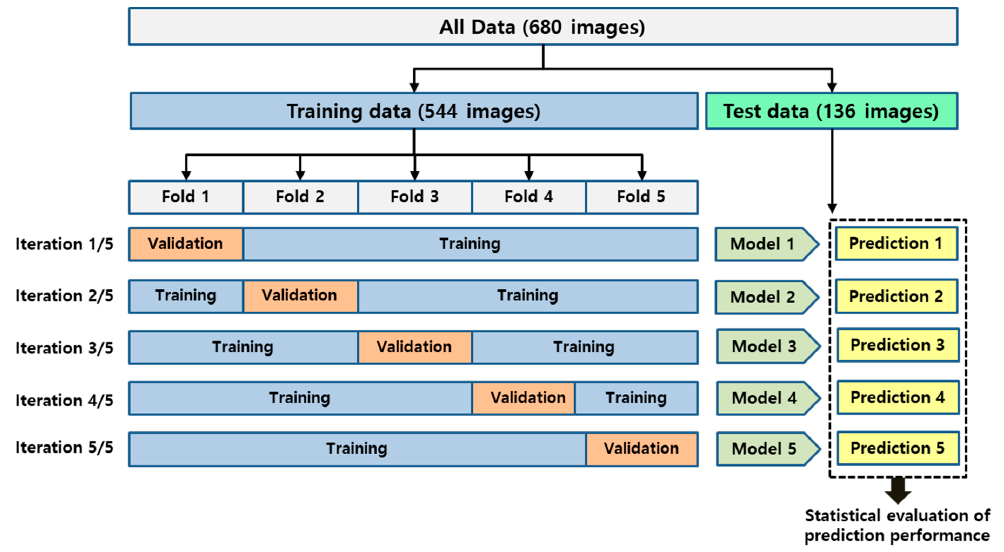
Figure 3. The overview of the performed 5-fold cross validation in this study.